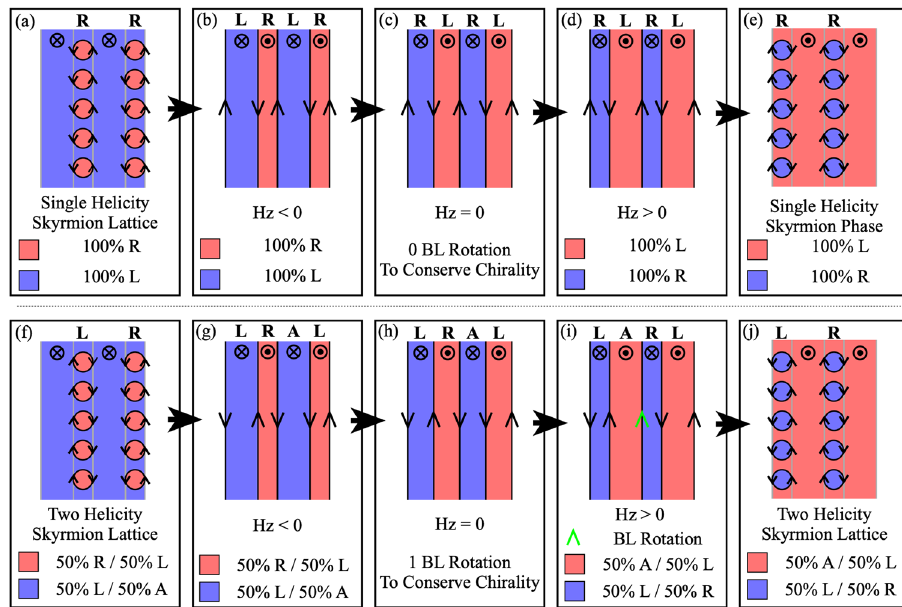
Fig. 6 Bloch-line evolution of Dzyaloshinskii – Moriya interaction- and dipole-stabilized magnetic spin textures. a – j Schematic illustration of the Block- line evolution for global a – e chiral and f – j achiral skyrmion lattice phases as perpendicular magnetic fi eld is applied from negative to positive (left to right images) saturation. The right-handed (R) and left-handed (L) Bloch-line helicity is depicted with a black-hue arrowheads along the perimeter of red/blue- colored features which represent positive/negative perpendicular magnetic domains. A green-hue arrowhead depicts a Bloch-line whose helicity changed compared to prior applied fi elds. For each ground state, the local and global Bloch-line helicity distribution is depicted for both perpendicular magnetization textures. Local/global Bloch-line helicity is shown above/below the spin texture